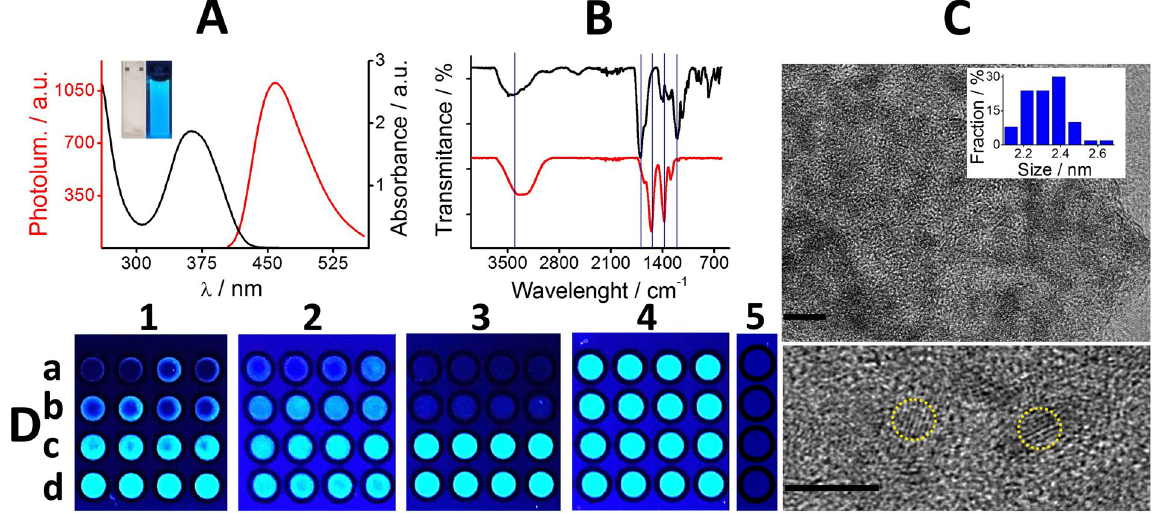
Figure 2. Characterization of the GQDs and the GQD-modified strip. ( A ) Absorbance (black line) and photoluminescent (red line) spectra. Iinset, a picture of the GQDs under UV (right) and visible (left) light, respectively. ( B ) FT-IR spectrum of citric acid (black line) and GQDs (red line), respectively. ( C ) TEM image (upper and bottom scale bars are 5 nm, respectively). Inset is the plot of particles size distribution. GQDs lattice planes are denoted by yellow circles. ( D ) Optimization of the GQDs-modified paper-based sensing platform in terms of fluorescence intensity and homogeneity of the sensing area. (1) Concentration of GQDs solution (a) 6.25, (b) 12.5, (c) 25 and (d) 50 mg/ml. (2) Volume of GQDs solution, (a) 1, (b) 2, (c) 3, and (d) 4 µ L. (3) GQDs pH value, (a) 4, (b) 6, (c) 8, (d) 13. (4) Number of additions of a volume of 4 µ L, (a) 1, (b) 2, (c) 3, and (d) 4 times. All of them placed into the wax-patterned areas from the nitrocellulose support. The concentration of GQDs solution is always 50 mg/ml except in (a). (5) 0 mg/ml GQDs (from a to d) used as control to discart other possible interferences. Experiments were performed in quadruplicate and represented in each row